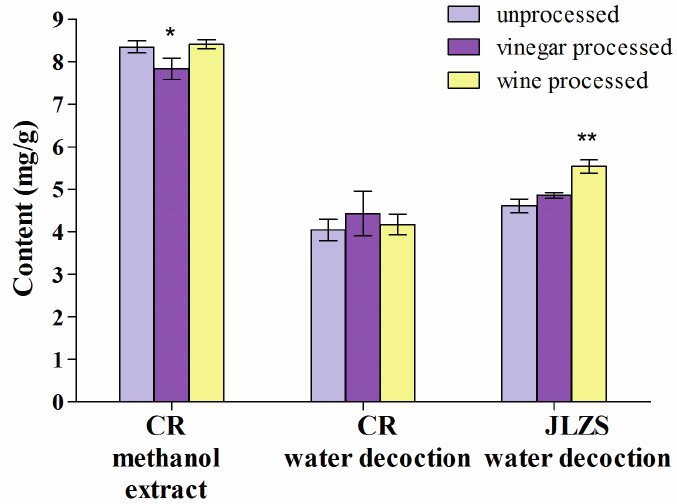
Figure 3. Alkaloid content in processed and unprocessed Corydalis Rhizoma. Corydalis Rhizoma (CR), Jin Ling Zi San (JLZS). Values are mean ± SD, n = 3, RSD < 6%. ** p < 0.01, * p < 0.05 of processed against unprocessed Corydalis